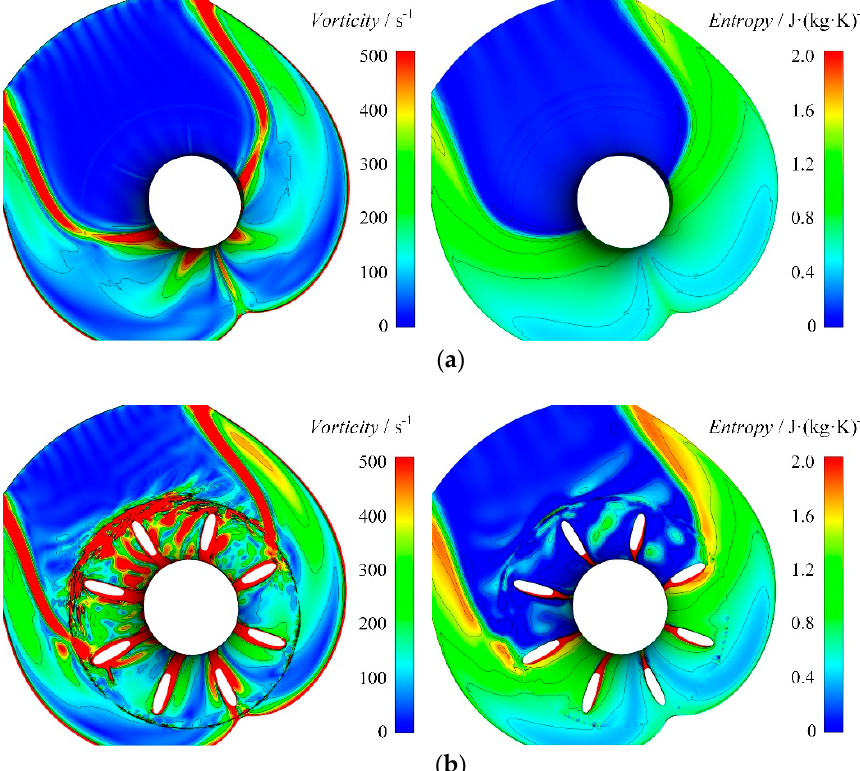
Figure 10. Flow conditions inside the spiral and annular convergence channels ( a ) without guide vanes and ( b ) with guide vanes.